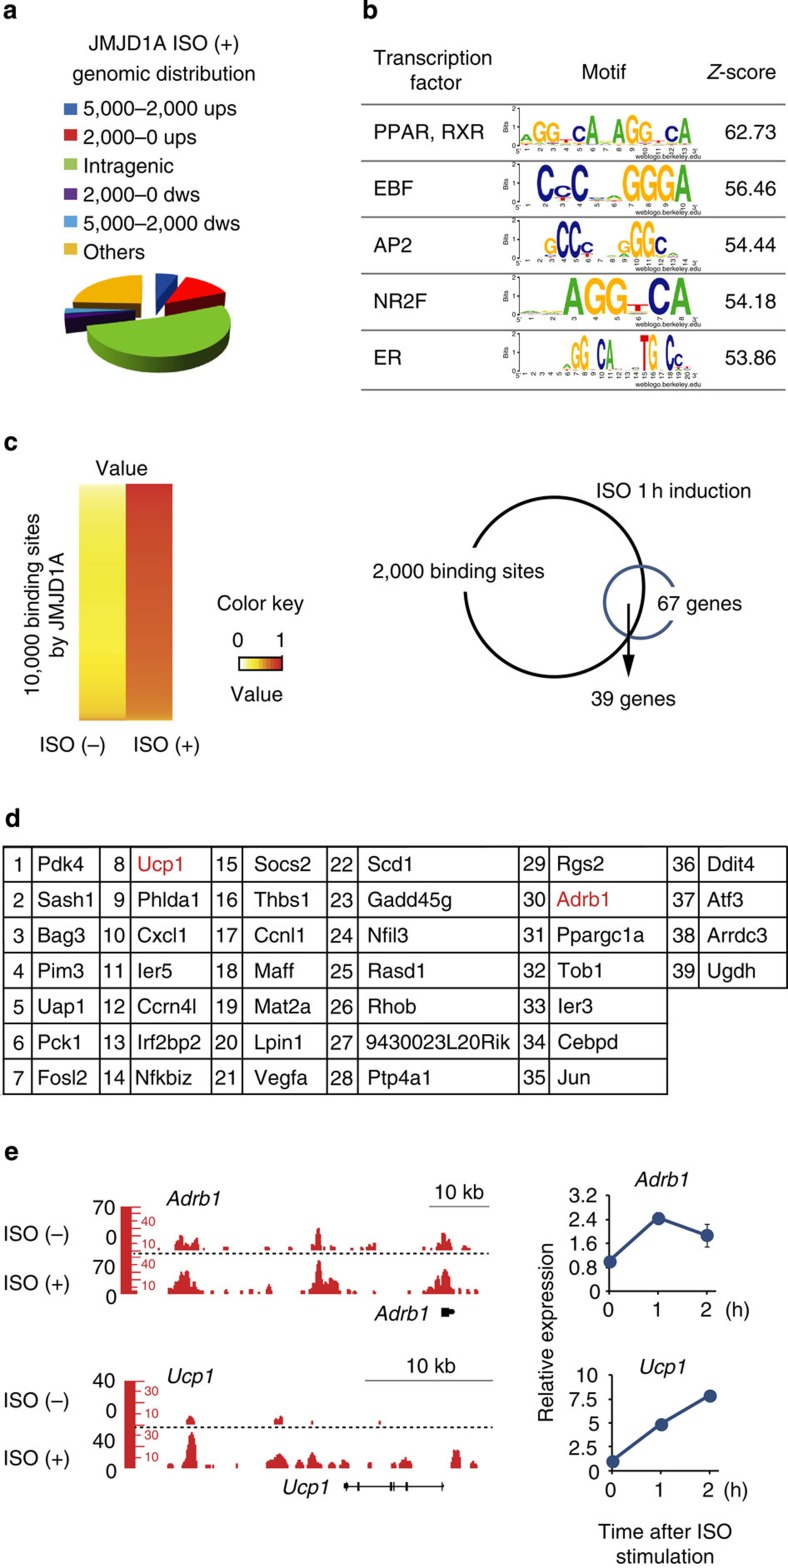
β-Adrenergic-dependent genomic localization of JMJD1A.(a) Genome-wide distribution of JMJD1A binding sites in ISO (1 μM for 2 h) treated iBATs. Ups, upstream; dws, downstream; ISO, isoproterenol. (b) Table depicting TF binding motifs enriched at constituent enhancers within JMJD1A binding regions relative to genomic background and associated Z-scores. (c,d) JMJD1A ChIP-seq and transcriptional microarray analysis performed in iBATs at day 8 of differentiation (day 8). Heatmap represents top 10,000 high SICER scored JMJD1A binding sites under ISO-plus condition (1 μM for 2 h). Colour intensity represents Z-score of JMJD1A binding sites under ISO-minus versus those under ISO-plus condition. The higher the (red/yellow) contrast it becomes, the higher ISO-induced JMJD1A recruitment to the given binding sites relative to ISO-minus. For reference, a colour intensity scale is included (c, left panel). Venn diagram showing the top 2,000 sites annotated ISO-induced JMJD1A binding and the number of ISO-induced genes >20.8-fold by ISO (1 μM for 1 h; c, right panel). The overlapping genes were listed in d. (e) Genome browser shots showing the ISO-induced JMJD1A recruitments on selected genomic regions analysed by ChIP-seq in iBATs (day 8) treated with ISO (1 μM) or vehicle for 2 h (left panel). mRNA levels of Adrb1 and Ucp1 in iBATs (day 8) after ISO (1 μM) treatment at the indicated time points. Data were presented as fold change relative to 0 h (mean±s.e.m.) of three technical replicates (error bars are too tiny to see; right panel).